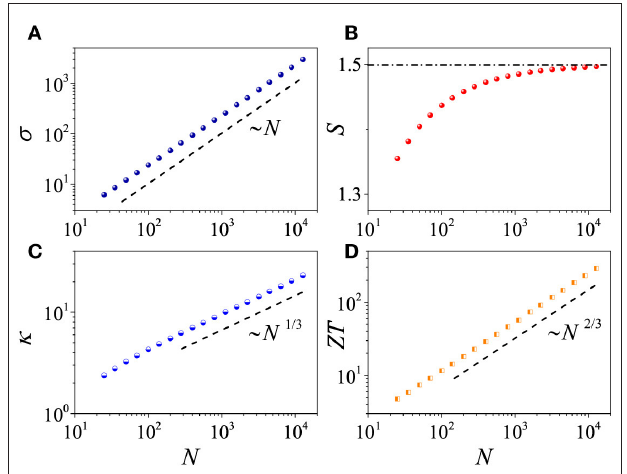
FIGURE 3 | (A) Electrical conductivity σ , (B) Seebeck coefficient S , (C) thermal conductivity κ , and (D) thermoelectric figure of merit ZT plotted as functions of the mean number N of particles in the system, for a one-dimensional diatomic hard-point gas. Parameter values are m 1 and = M e 3 for the masses, T 1, µ 0, and k B 1, with the system length = = = = = 3 set equal to the number of particles. Adapted with permission from Luo et al. [103]. Copyright © 2018 American Physical